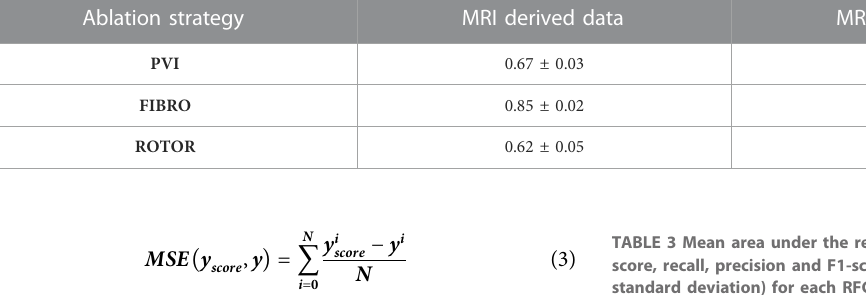
TABLE 2 Mean AUC score on independent hold-out test set (with standard deviation) for each RFCA strategy and type of data. Ablation strategy